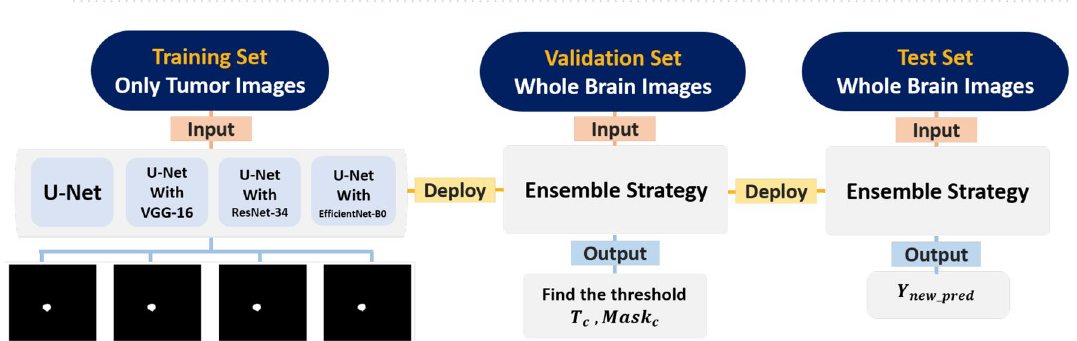
Figure 2. Post-contrast T1-weighted MRI per patient.